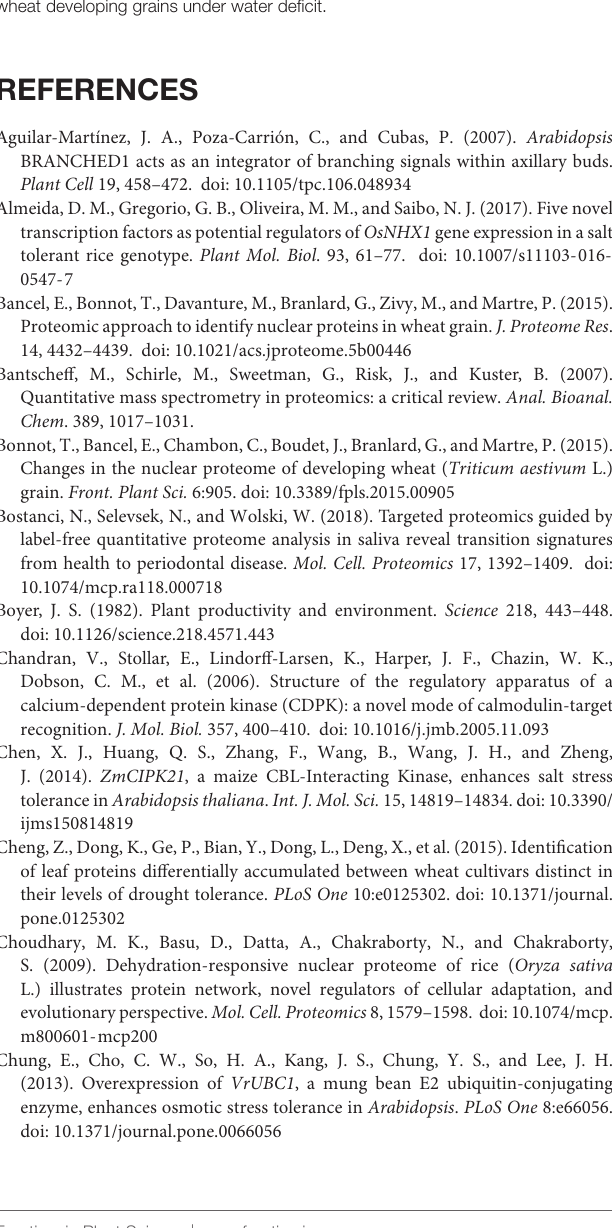
under water deficit.